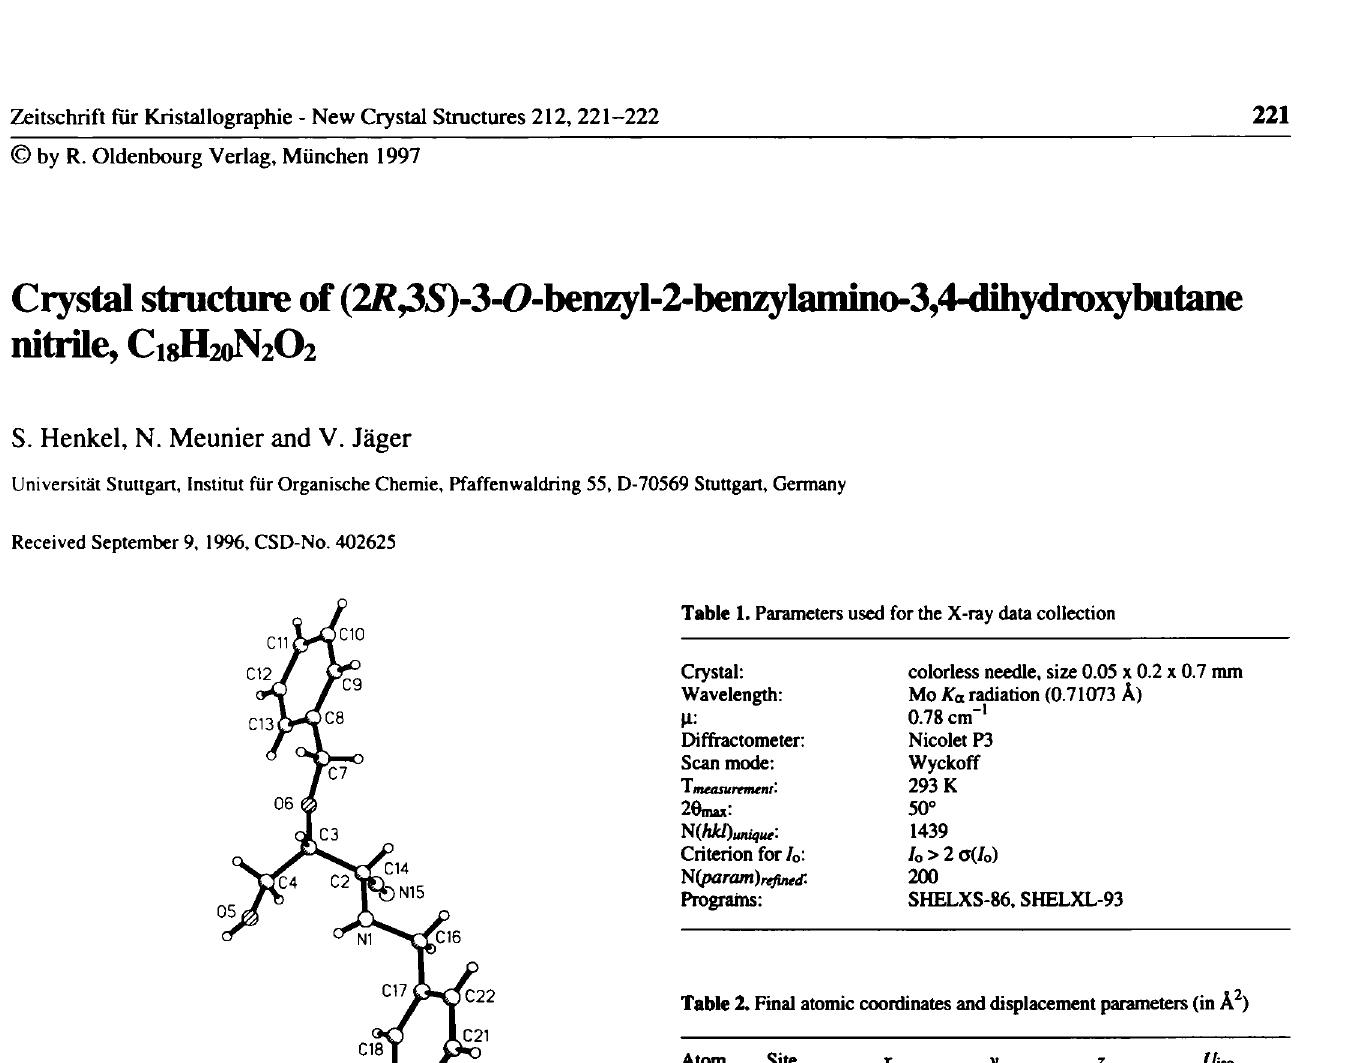
Table 2. Final atomic coordinates and displacement parameters (in Ä 2 )